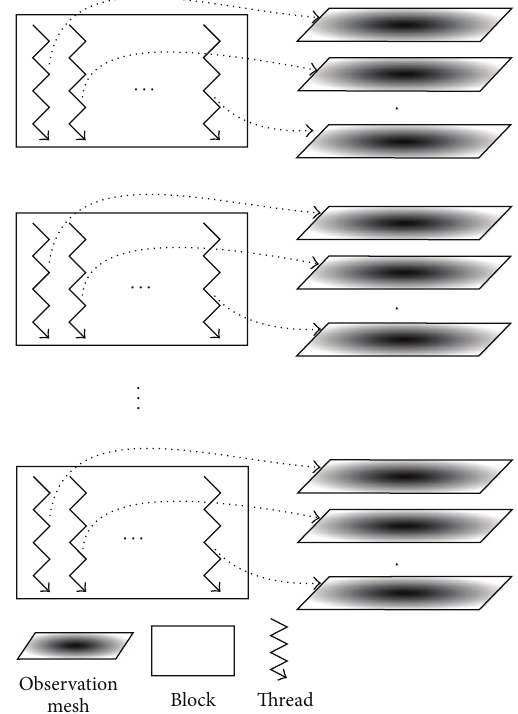
Figure 5: Partitioning by prisms using different memory